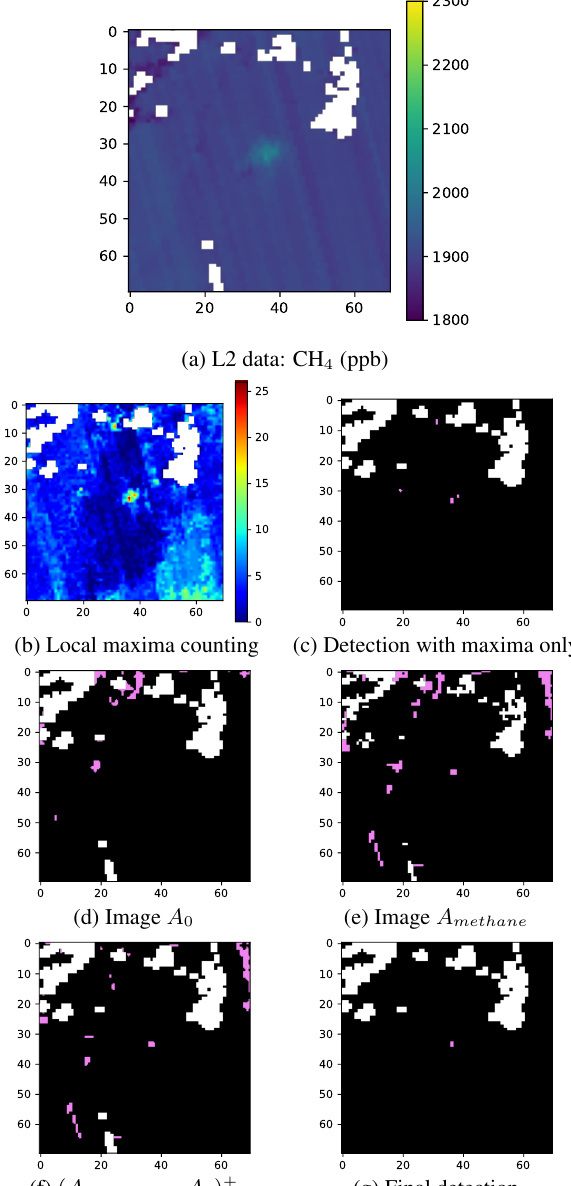
Figure 5. In the image (a), a methane plume is visible in green. Each other image correspond to a part of the detection algorithm, from the counting of maxima to the final detection. Detected pixels are in